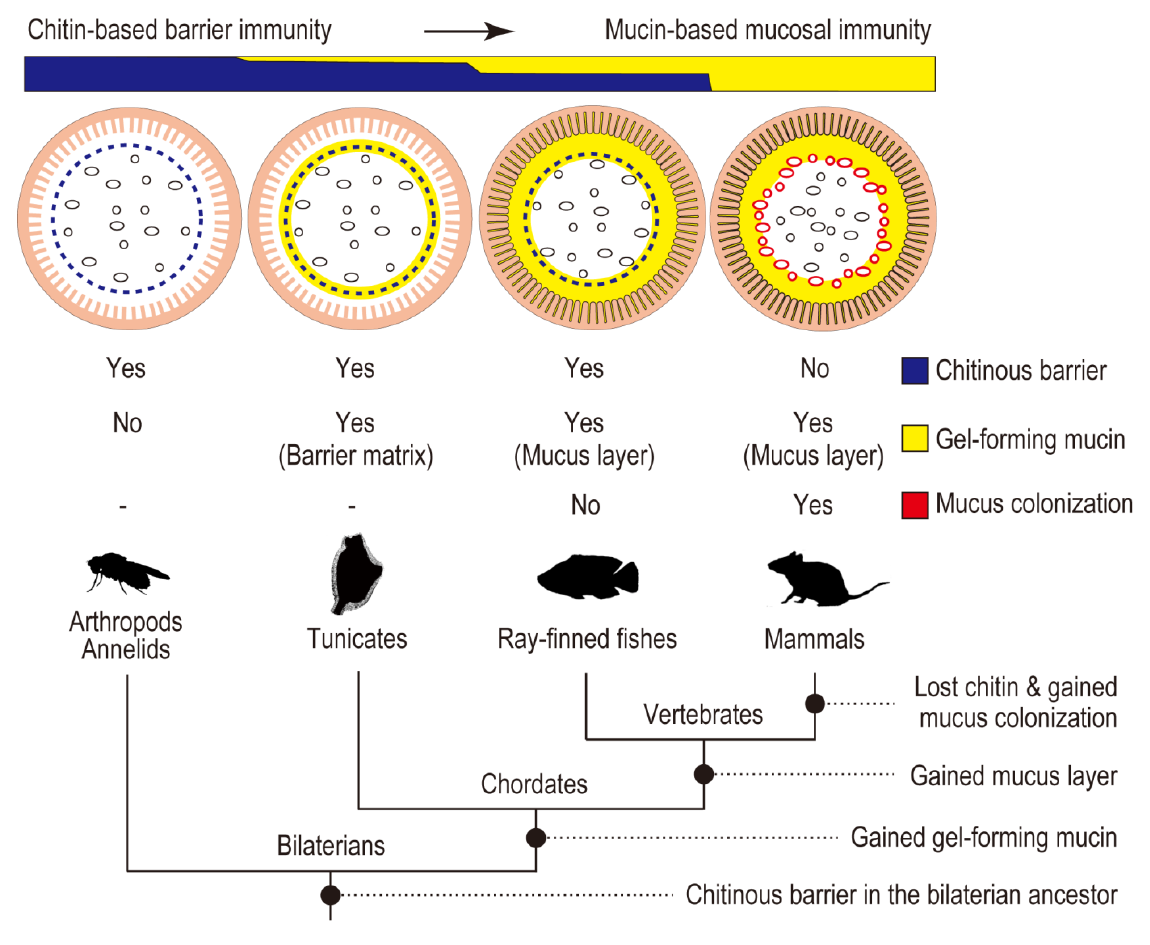
FIGURE 2: Transition of the gut mucosal surface in chordates. For animal groups shown in pictograms, intestinal barrier structures are illustrated above. Gut microbes are shown as ovals and circles. Invertebrate outgroups share a peritrophic matrix, although the presence of chitin remains unclear beyond arthropods and annelids. Tunicates possess chitin nanofibers embedded in matrix substances, including gel-forming mucins. Filter-fed microbes are confined to the luminal space. Ray-finned fishes harbor indigenous gut microbes that are sepa- rated from the surrounding mucus layer by chitinous barriers. Mammals lost chitin, and the mucus layer is colonized by indigenous mi- crobes. “Yes” or “No” indicates the presence or absence of the item listed on the right, respectively. Color-codes are shown in boxes. The bottom tree diagram depicts animal phylogeny, annotated with a series of events that account for gradual changes of the gut mucosa in chordates. We propose a transition from a chitin-based ancestral condition to a mucin-based derived state (top). Adapted from Nakashima et al. Nat Commun 9: